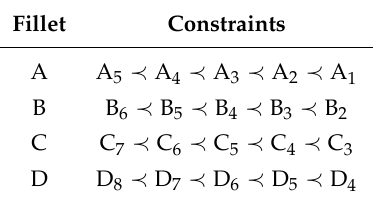
Table 6. The constraints based on the storage days of the samples.